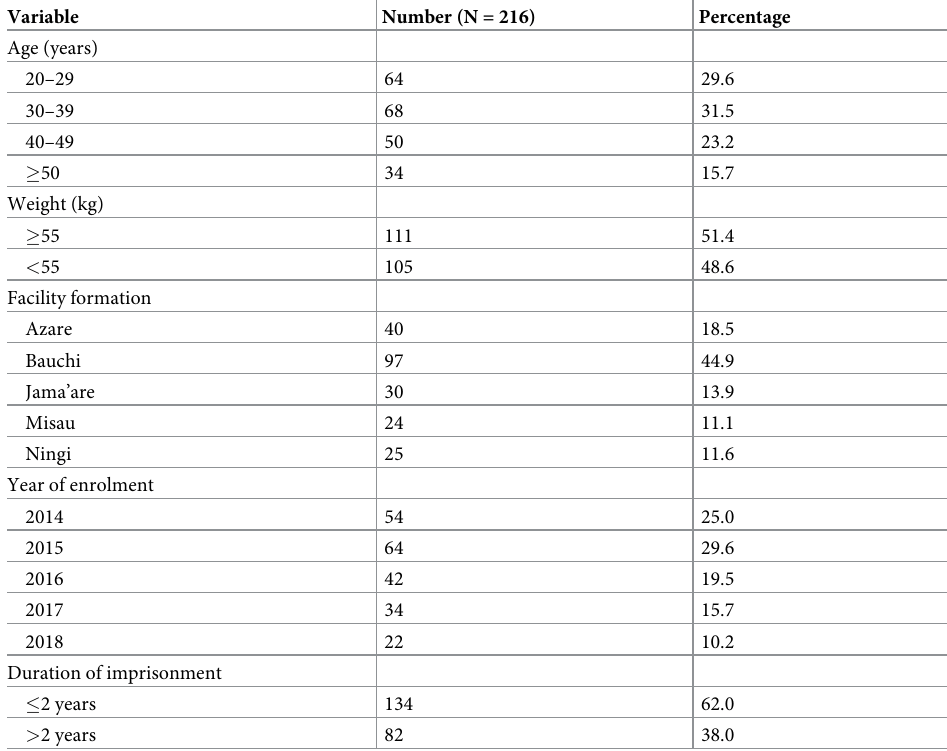
Table 1. Socio-demographic characteristics of TB patients treated in five main prison settings in Bauchi State from January 2014 to December